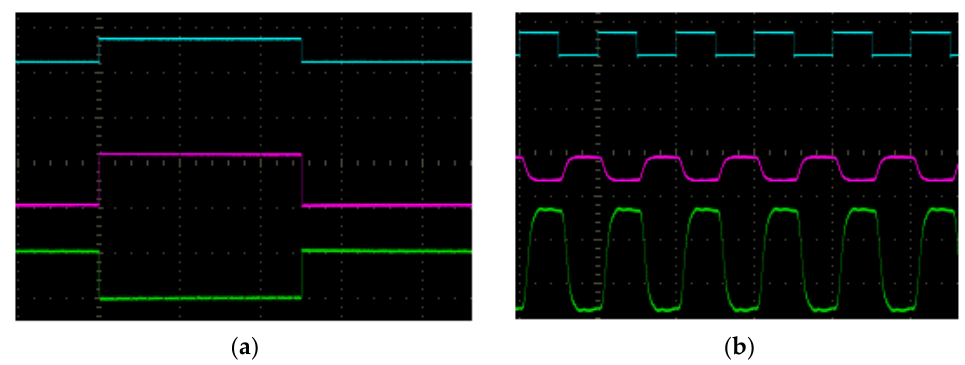
Figure 16. AC signal waveforms for the pulse frequency: ( a ) 1 kHz; ( b ) 100 kHz.